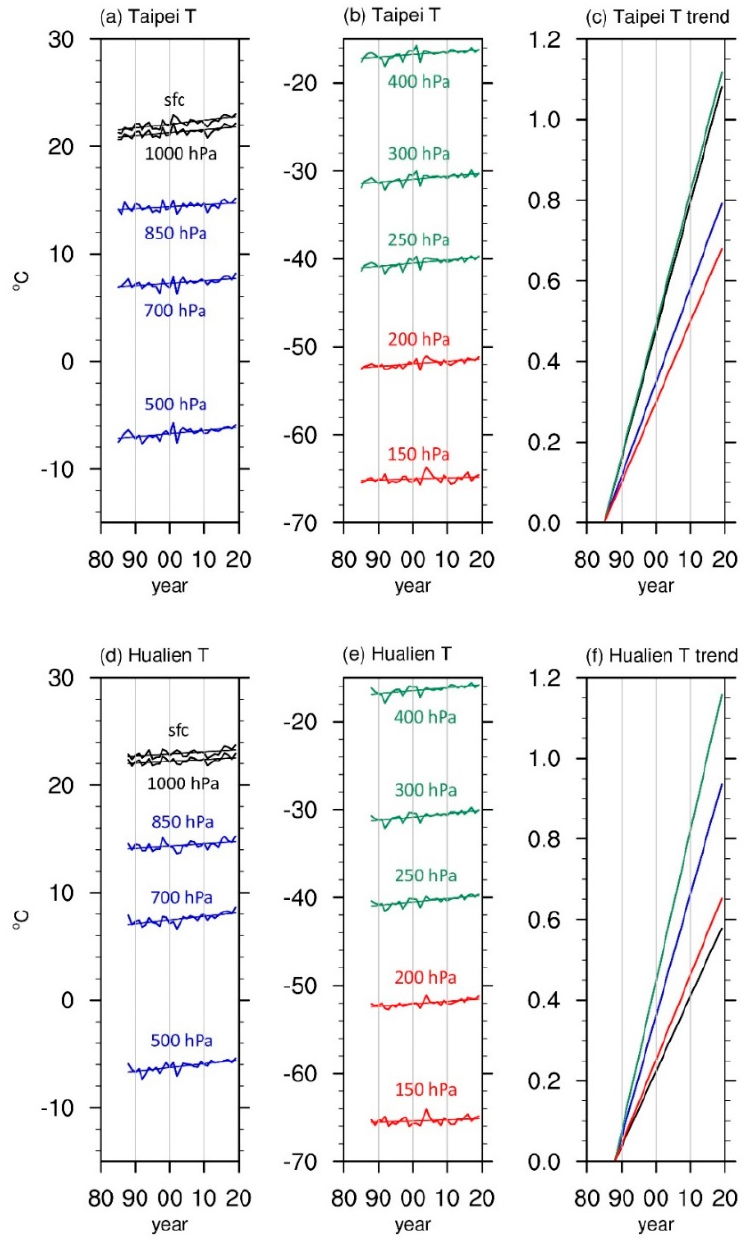
Figure 4. Decadal trend of the ( a , b ) annual mean temperature at each pressure layer, ( c ) each group of pressure layers (subtracting the trend value of the first observation year) over the Taipei sounding station, unit: °C. ( d – f ) are the same as ( a – c ) but for the Hualien sounding station. The colors indicate the grouped pressure layers (black: the surface to 1000 hPa; blue: 850 hPa to 500 hPa; green: 400 hPa to 250 hPa; red: 200 hPa to 150 hPa). The thin line at each pressure layer denotes the corresponding trend of the variations.